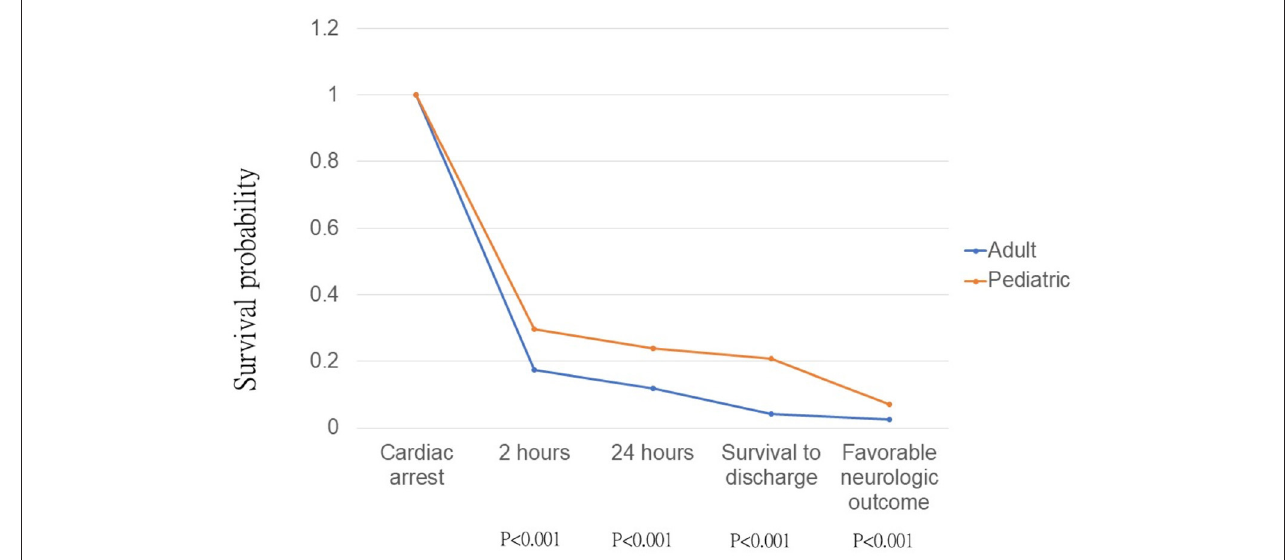
FIGURE 2 | Kaplan-Meier type plots for pediatric and adult out-of-hospital cardiac arrest patients, p -value was calculated by log-rank test.